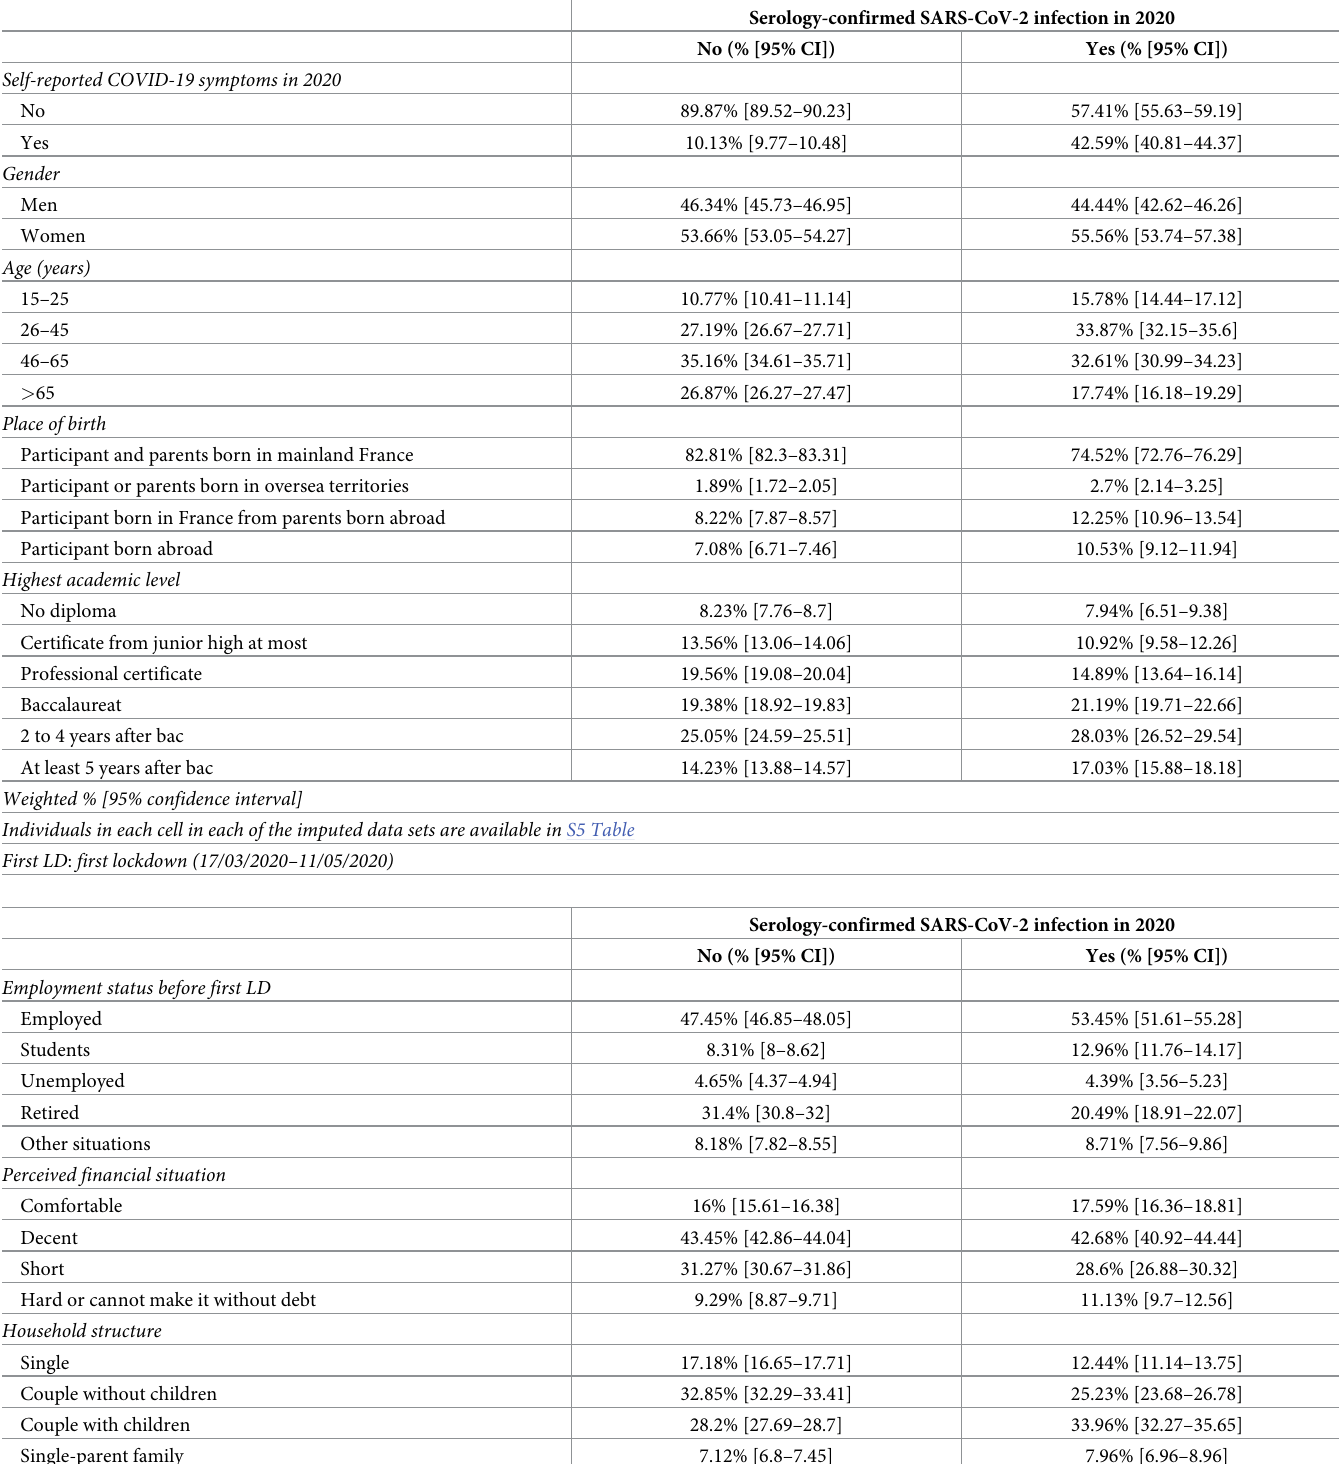
Table 3. Prevalence of self-reported COVID-19-like symptoms and covariates according to serology-confirmed SARS-CoV-2 infection in 2020, weighted by study weights, pooled from five imputed data sets.